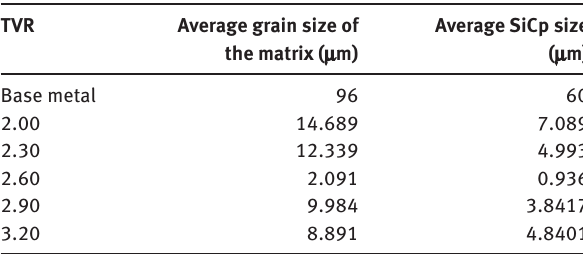
Table 5: Effect of TVR on matrix grain size and reinforcement size.